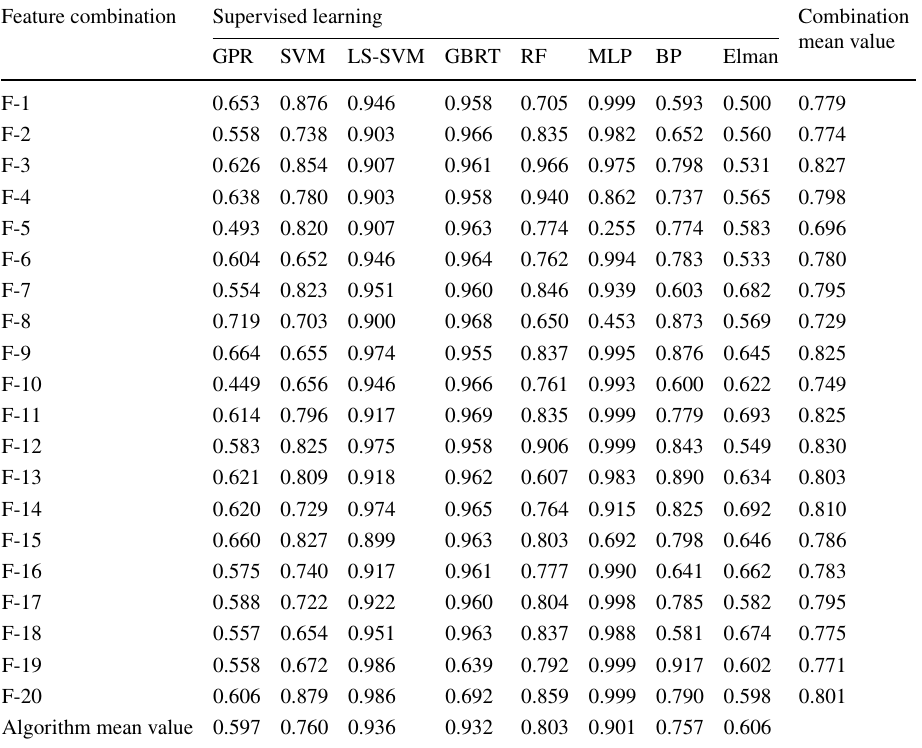
Feature combination Supervised